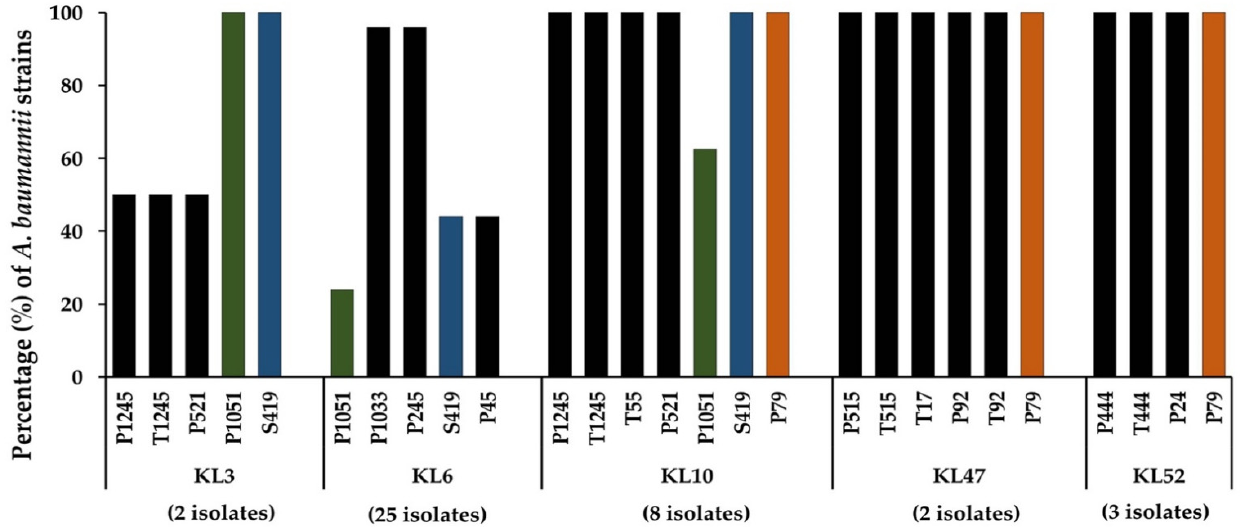
Figure 2. Lytic activity of 18 phages on 49 multidrug-resistant A. baumannii clinical isolates of capsular types KL3, KL6, KL10, KL47, and KL52. Phage lysates were spotted onto the lawns formed by A. baumannii . Phages P1051, S419, and P79 were able to infect bacteria with three distinct capsular types. Three different color bars indicate phages P1051, S419, and P79 that could infect three capsular types.